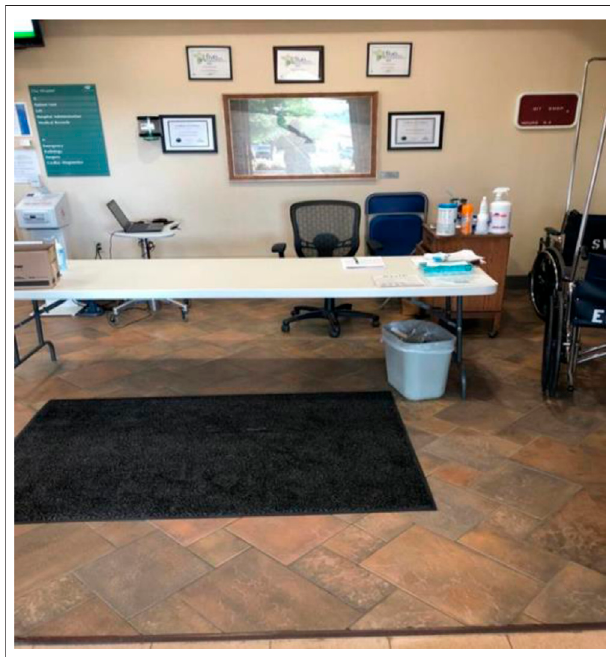
FIGURE3| Waitingarea:HospitalinCarmel,Indiana(2019),photograph by Lisann Good-Burton.